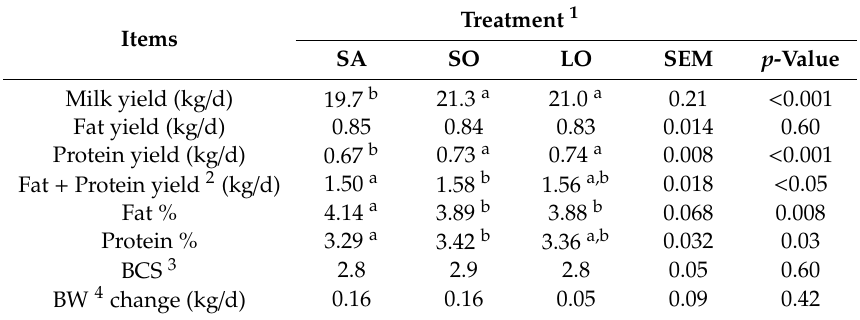
Table 4. E ff ect of C 18 fatty acid source in the supplementary concentrate on milk production and milk composition body weight and body condition score of lactating dairy cows o ff ered a pasture based diet (least square means ± SEM). Treatment Items